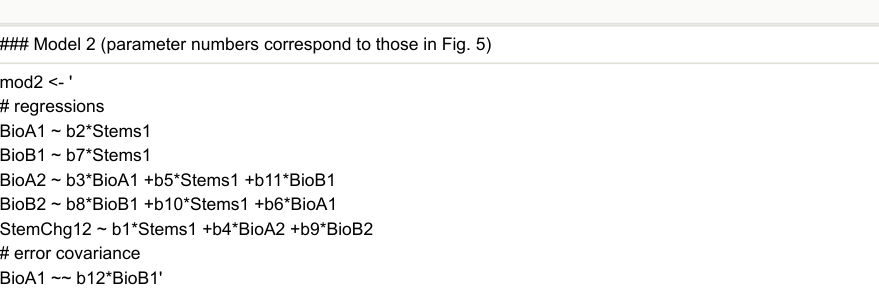
Code for estimating Model 2. Parameters are now labelled b1-12.